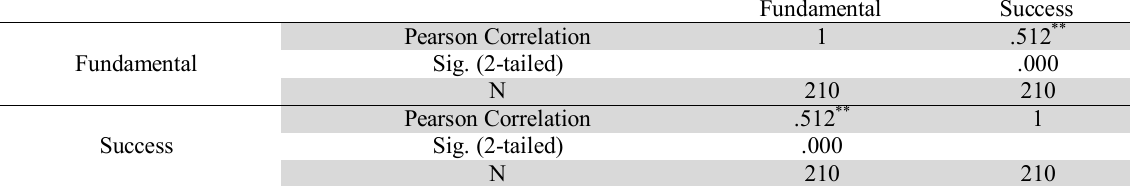
Fundamental Success